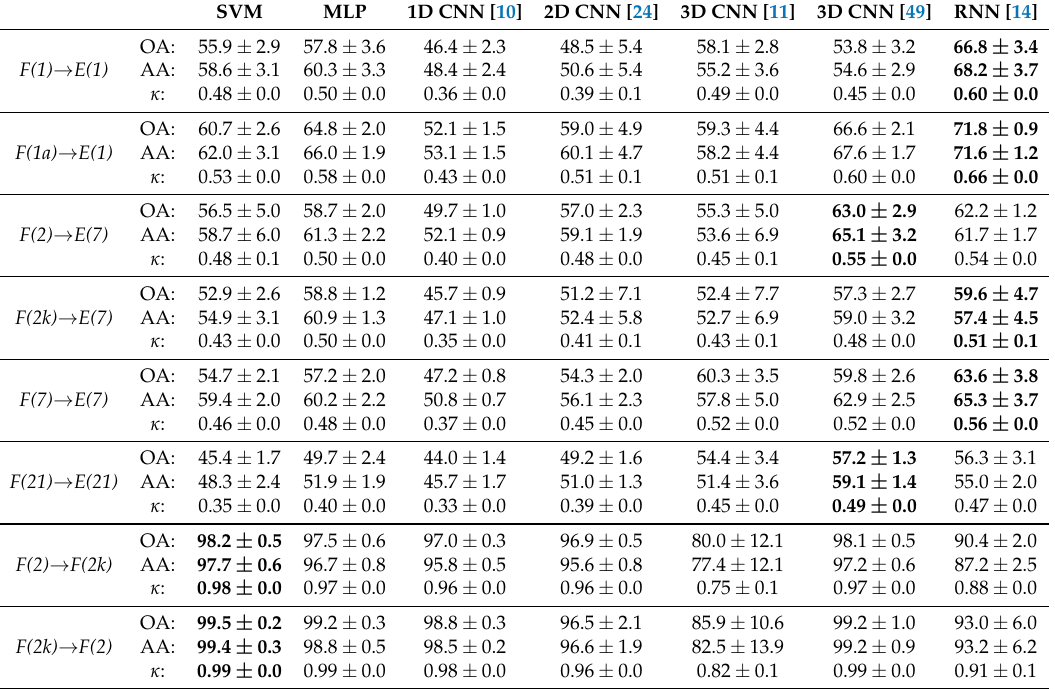
Table 2. The results of experiments for the inductive scenario (HIC). In consecutive rows values of Overall Accuracy (OA, %), Average Accuracy (AA, %) and Cohen’s kappa coefficient ( κ ) are presented for each image pair. The best OA scores are emphasized.